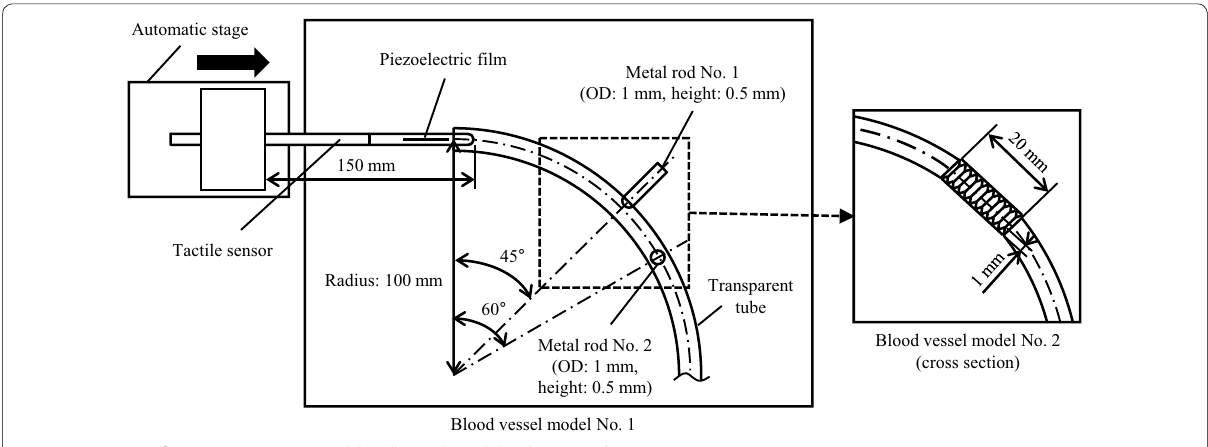
Fig. 8 Insertion of prototype sensor into blood vessel model (schematic